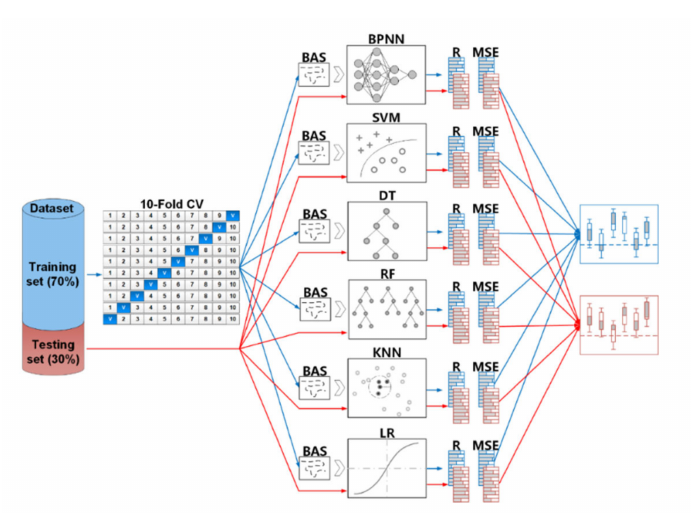
Figure 3. Flowchart of the process of tuning Machine learning (ML) algorithms by BAS.